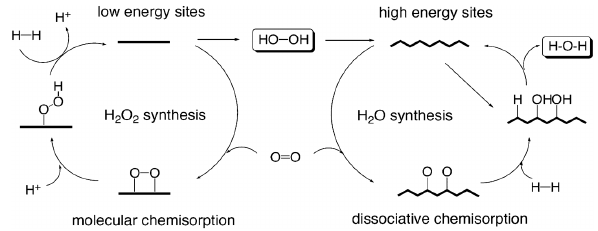
Figure 18. Possible pathway for the synthesis of H 2 O 2 and H 2 O on mono- and bimetallic Pd–Au 761